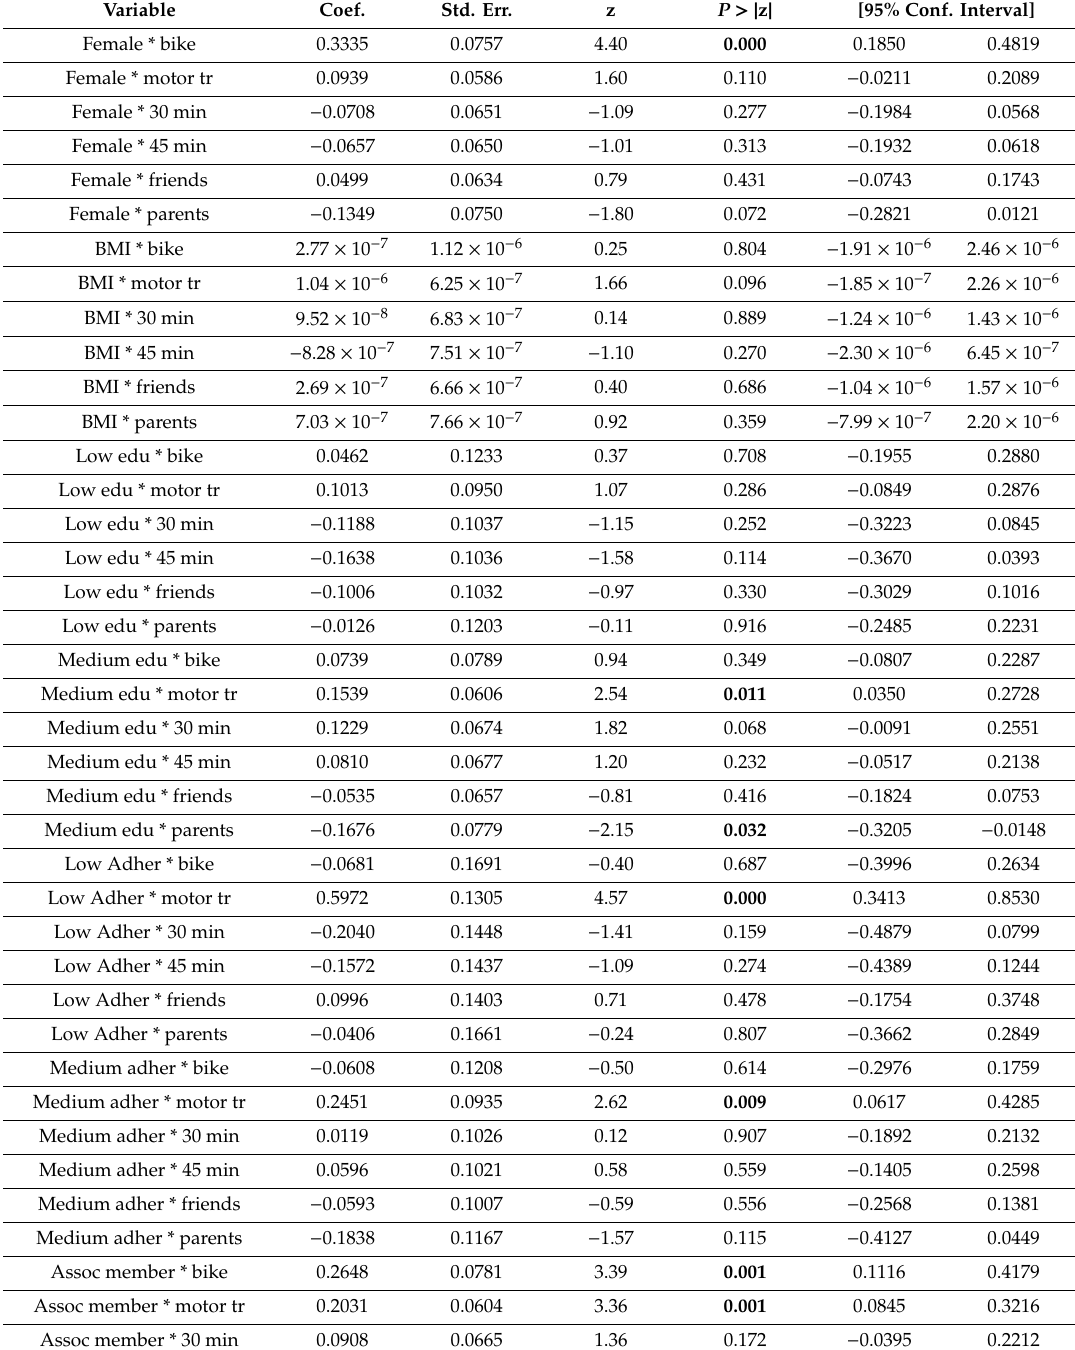
Table A5. Analysis of interaction e ff ects driving adolescents’ preferences: Adolescents’ socio-demographics and personal